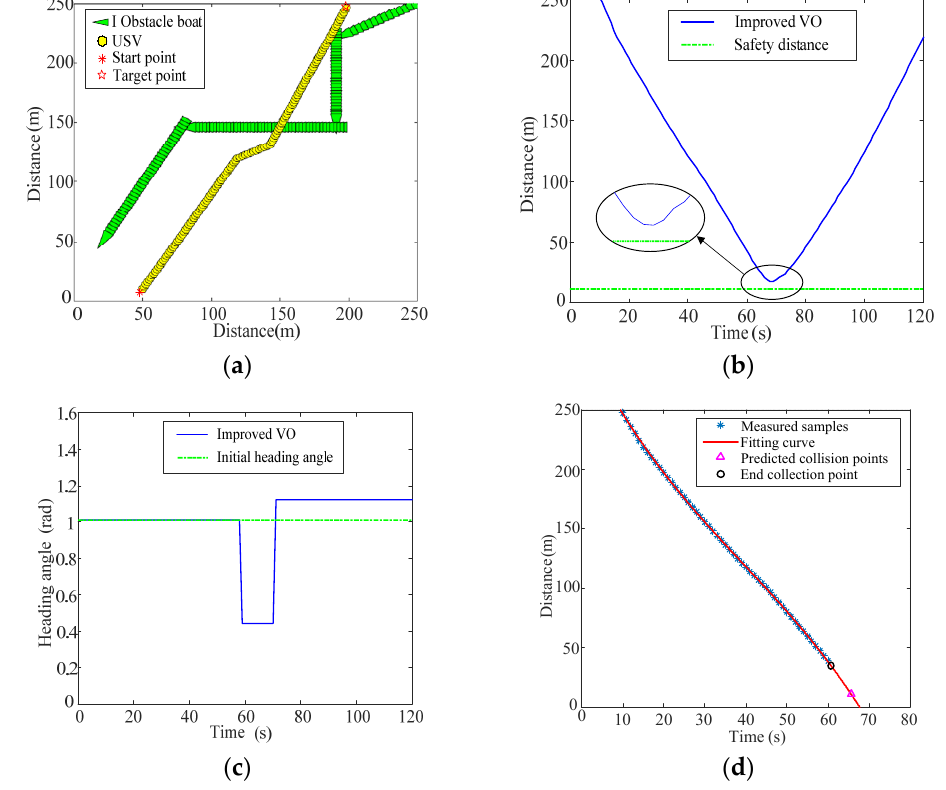
Figure 5. Obstacle collision time prediction and obstacle avoidance simulation: ( a ) path simulation; ( b ) relative distance between USV and obstacle ship; ( c ) the change in USV heading angle; ( d ) curve fitting and collision time prediction.